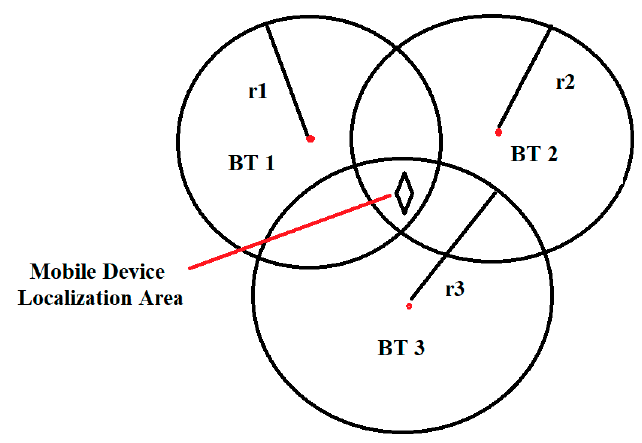
Figure 2. Mobile device location area using RSSI-based trilateration method.